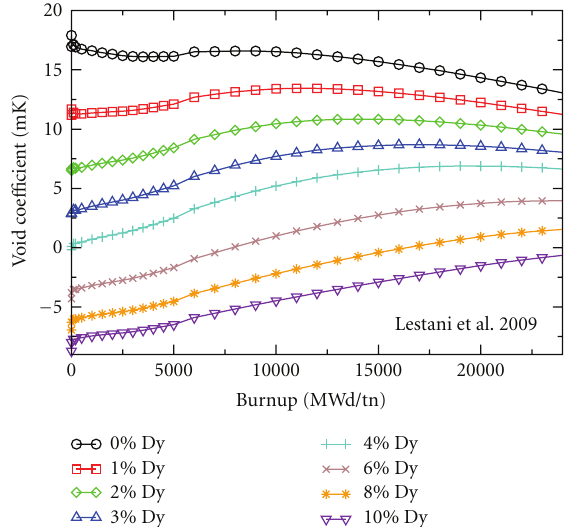
Figure 3: Evolution of coe ffi cient with burnup for di ff erent Dy